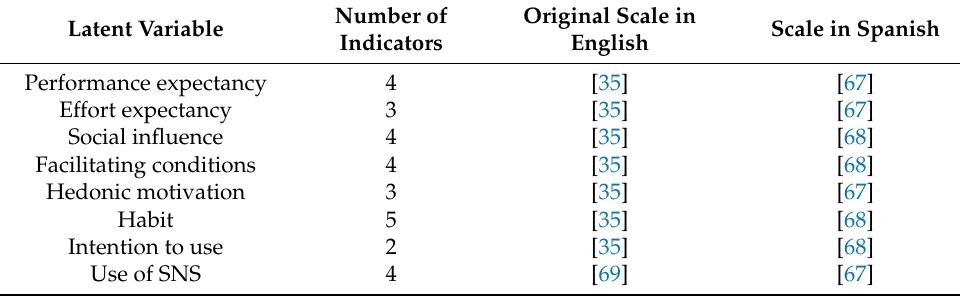
Table 2. Summary of measurement scales.